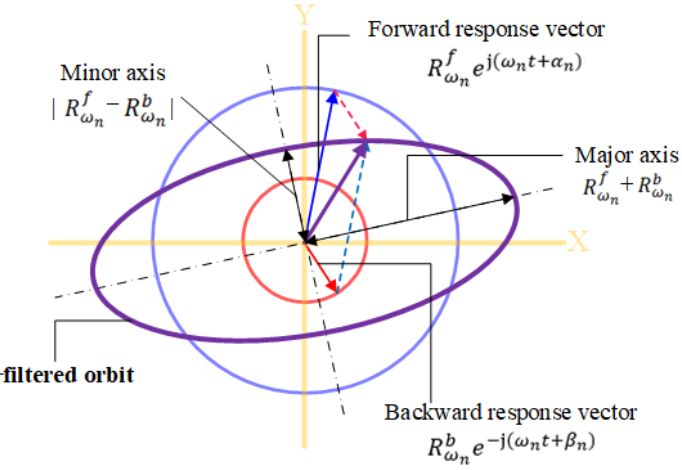
Figure 2. Full-spectrum construction model.